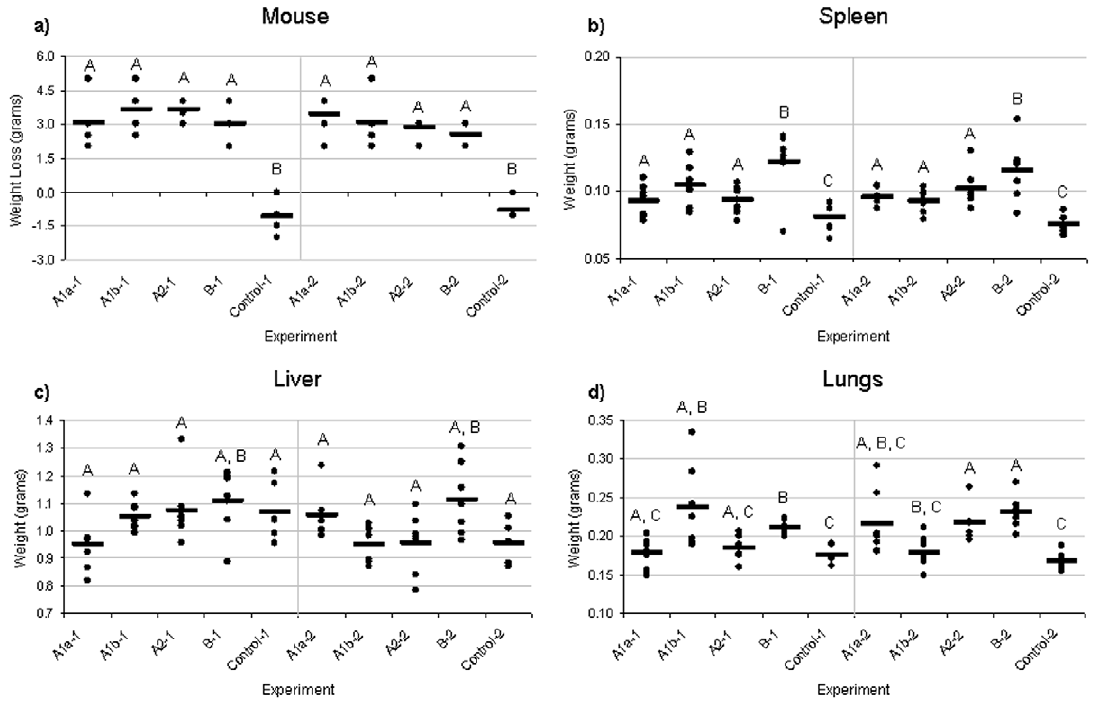
Figure 4. Weight loss and spleen, liver and lung weights for mice infected with F.tularensis A1a, A1b, A2, and type B. C57BL/6J mice (n=14/group) were challenged intradermally with 10-20 CFU of F. tularensis A1a, A1b, A2, and type B. Mice were weighed prior to infection and at time of death. Organs were harvested and weighed at time of death. A ) Mouse weight (grams) for each infection group and both control groups. No statistical difference was observed between round 1 and round 2. B ) Spleen weight (grams) for each infection group and both control groups. No statistical difference was observed between round 1 and round 2. C ) Liver weight (grams) for each infection group and both control groups. No statistical difference was observed between round 1 and round 2. D ) Lung weight (grams) for each infection group and both control groups. A statistical difference was observed between round 1 and round 2. For all graphs, significant differences (p , 0.05) in Log 10 CFU within round 1 infections and within round 2 infections are shown by different letters (A, B, etc.). If two strains have the same letter, no significant differences were identified between them.